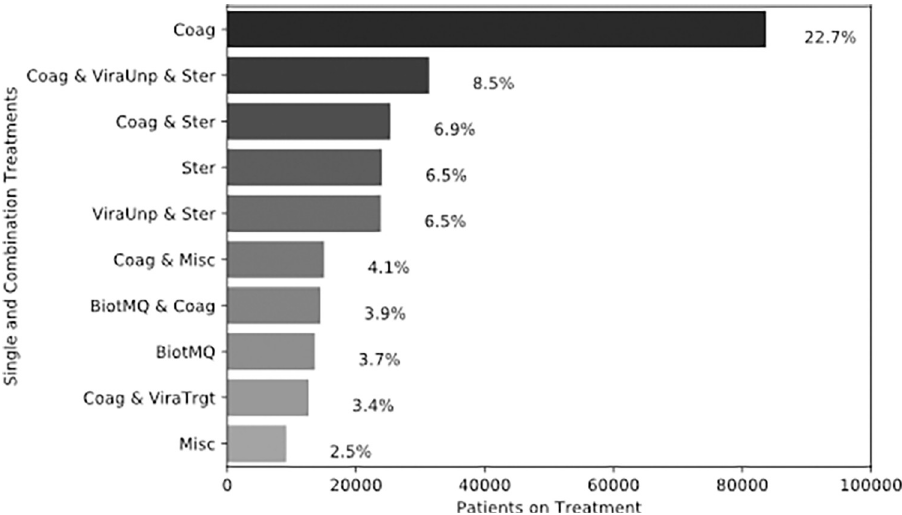
Fig 3. Top 10 prescribed treatments to